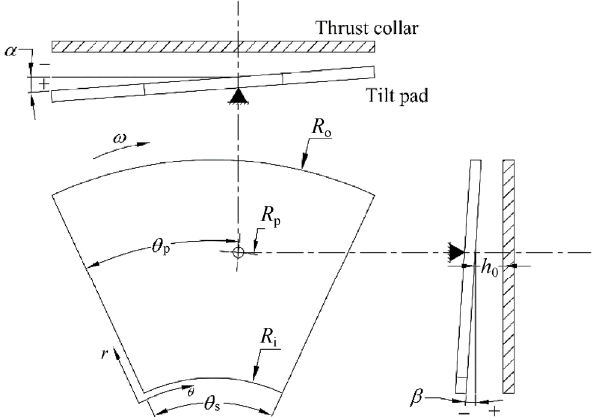
Fig. 1 Bearing model for flow factors simulation. Fig. 2 Geometry model of the tilt